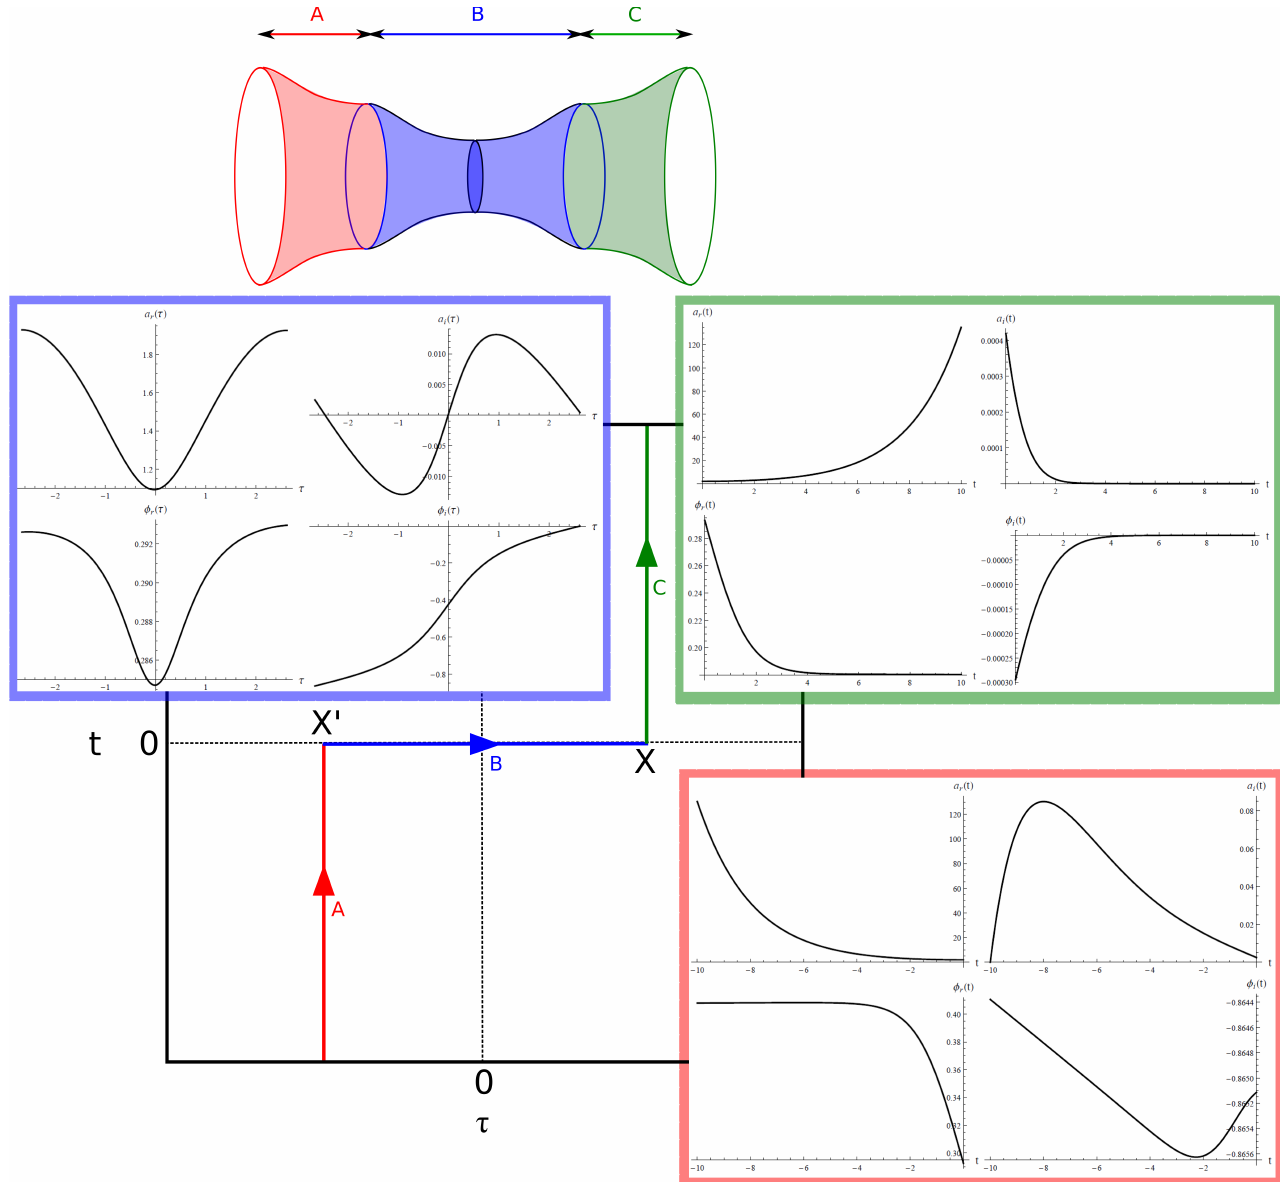
Figure 7. Complex time contours and numerical solution of Re a , Im a , Re φ , and Im φ for Equation (58). The top figure is the physical interpretation of the wormhole. Part A (red) and C (green) are Lorentzian, and Part B (blue) is Euclidean